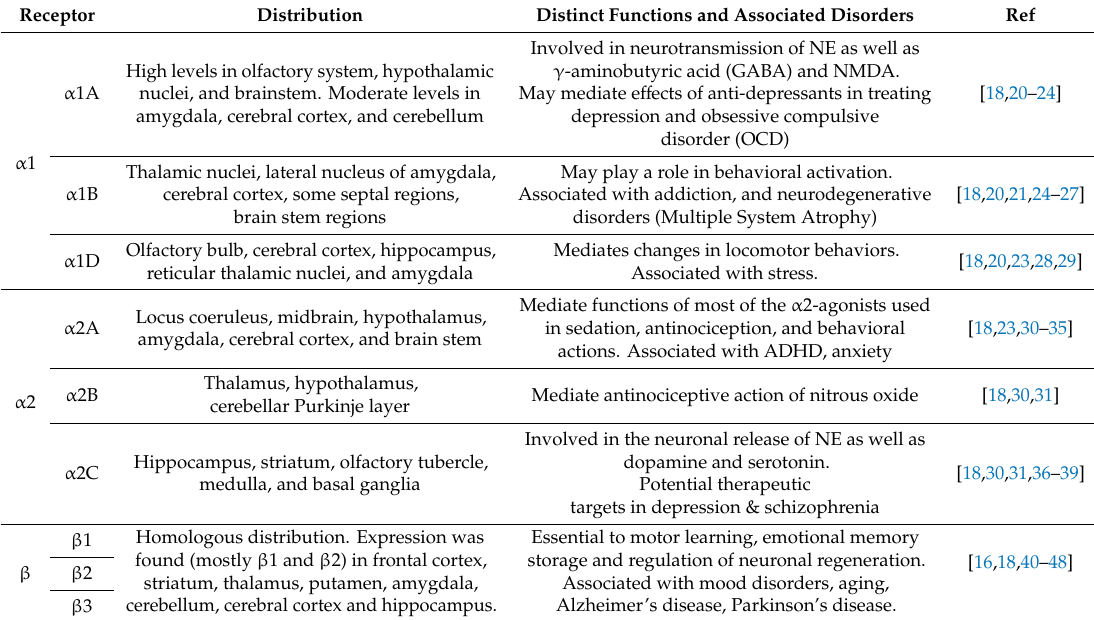
Table 1. Brain distribution of AR subtypes and their associated brain